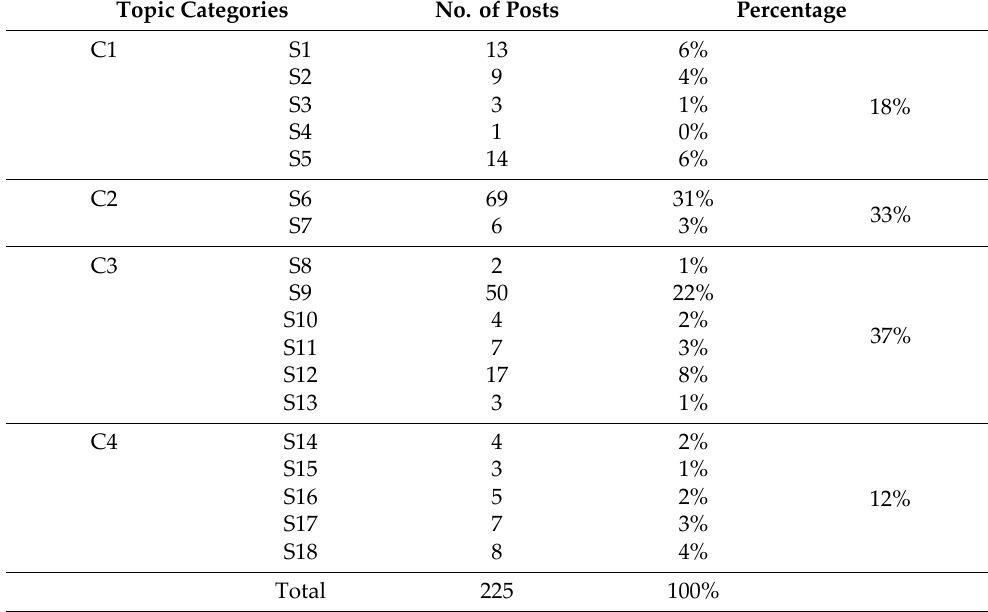
Table 6. Topic categorization of video from April 2022.